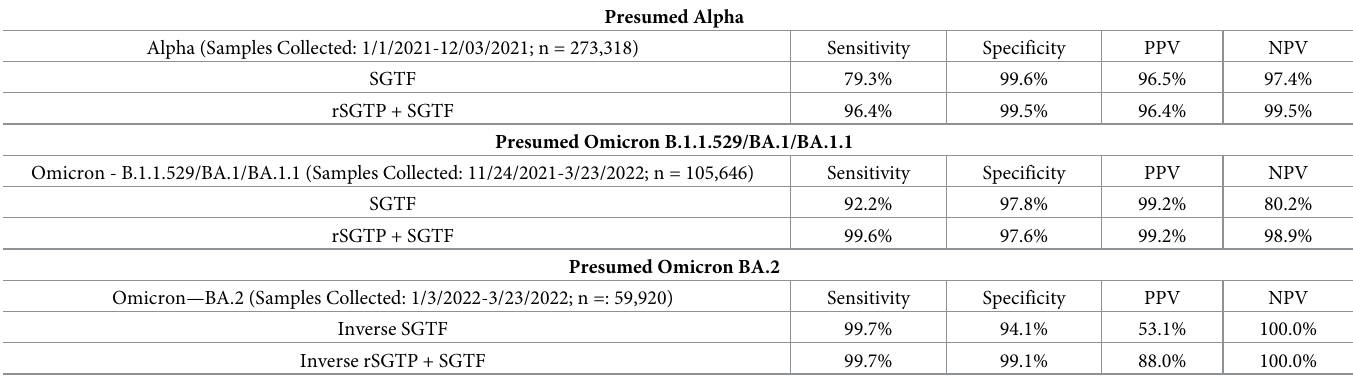
Table 3. Sensitivity, specificity, PPV, and NPV of proxy calculations by lineage.